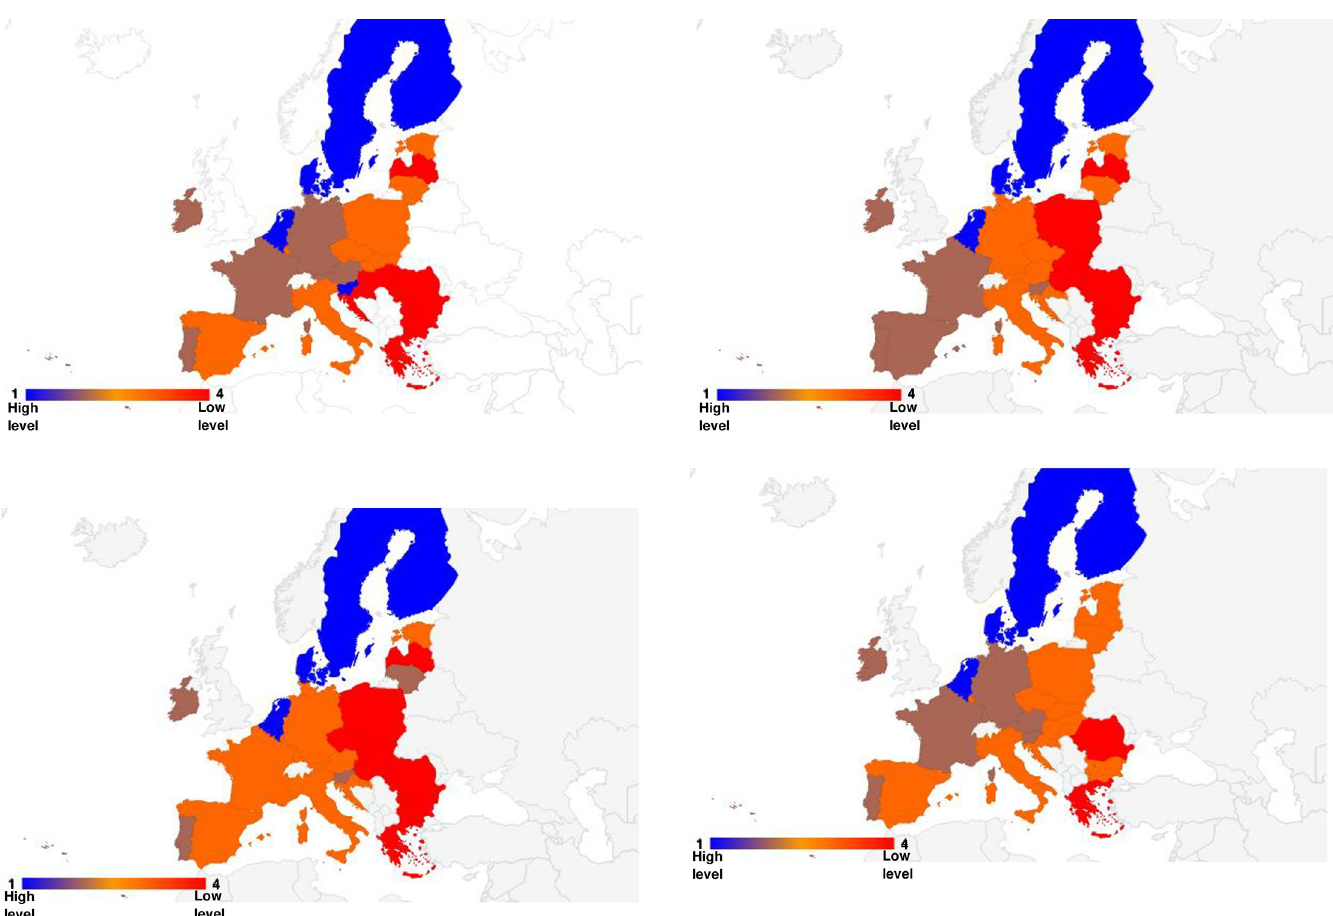
Fig 4. Division of the EU countries into similar classes in terms of the level of development of digitalization of enterprises (a- all enterprises, b–small enterprises, c- medium enterprises, d-large enterprises) (own elaboration).